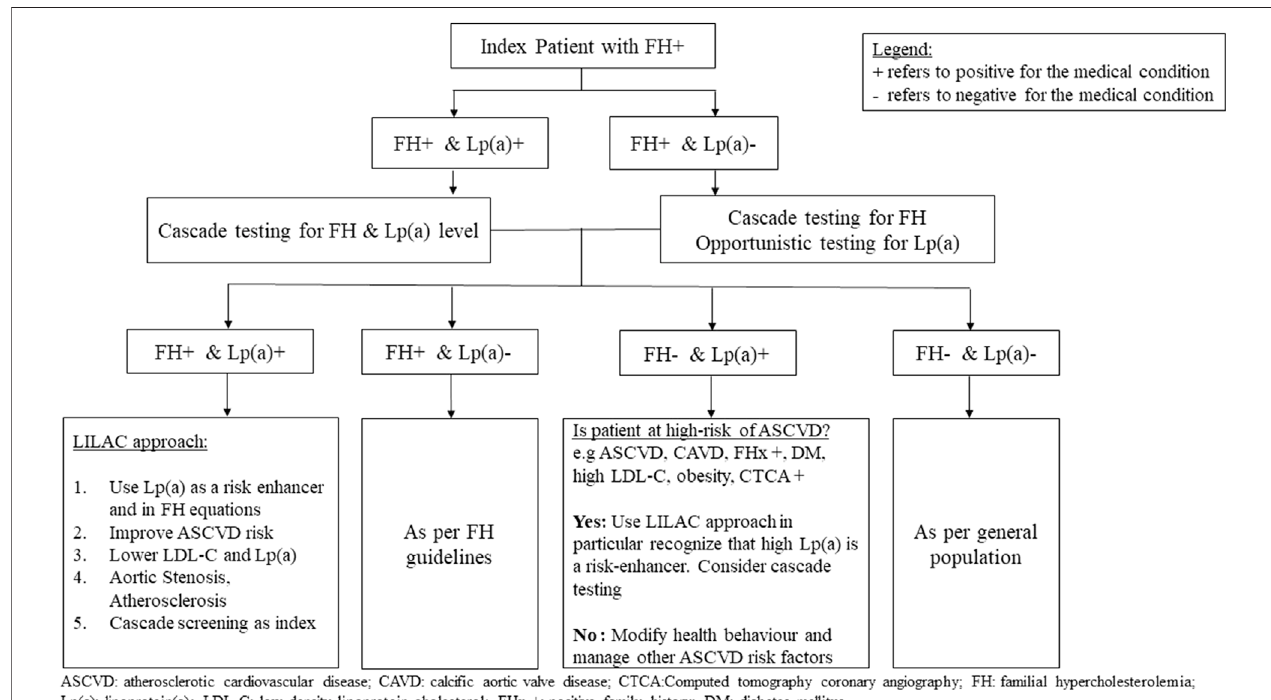
FIGURE 7 | Proposed algorithm for the management of relatives after cascade testing for hyper-lipoprotein (a) from probands with familial hypercholesterolemia.